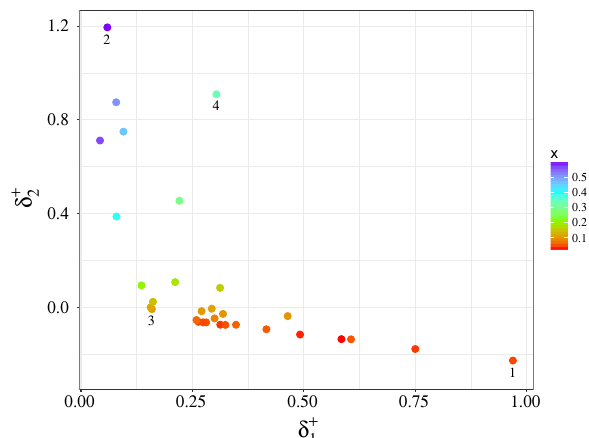
Fig. 3 The δ parameter space of the simple illustrative example: δ + form the axes and color indicates the respective value of x . Note that only δ + is shown because for this problem the δ − i the same information. Labelled points are the same as those labelled